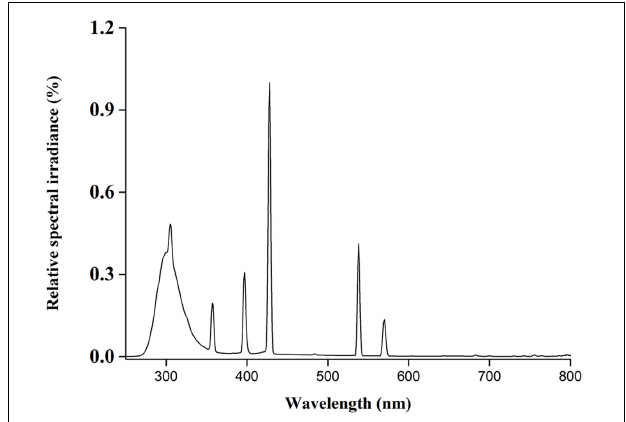
FIGURE 1 | The relative spectral irradiance of the UV-B